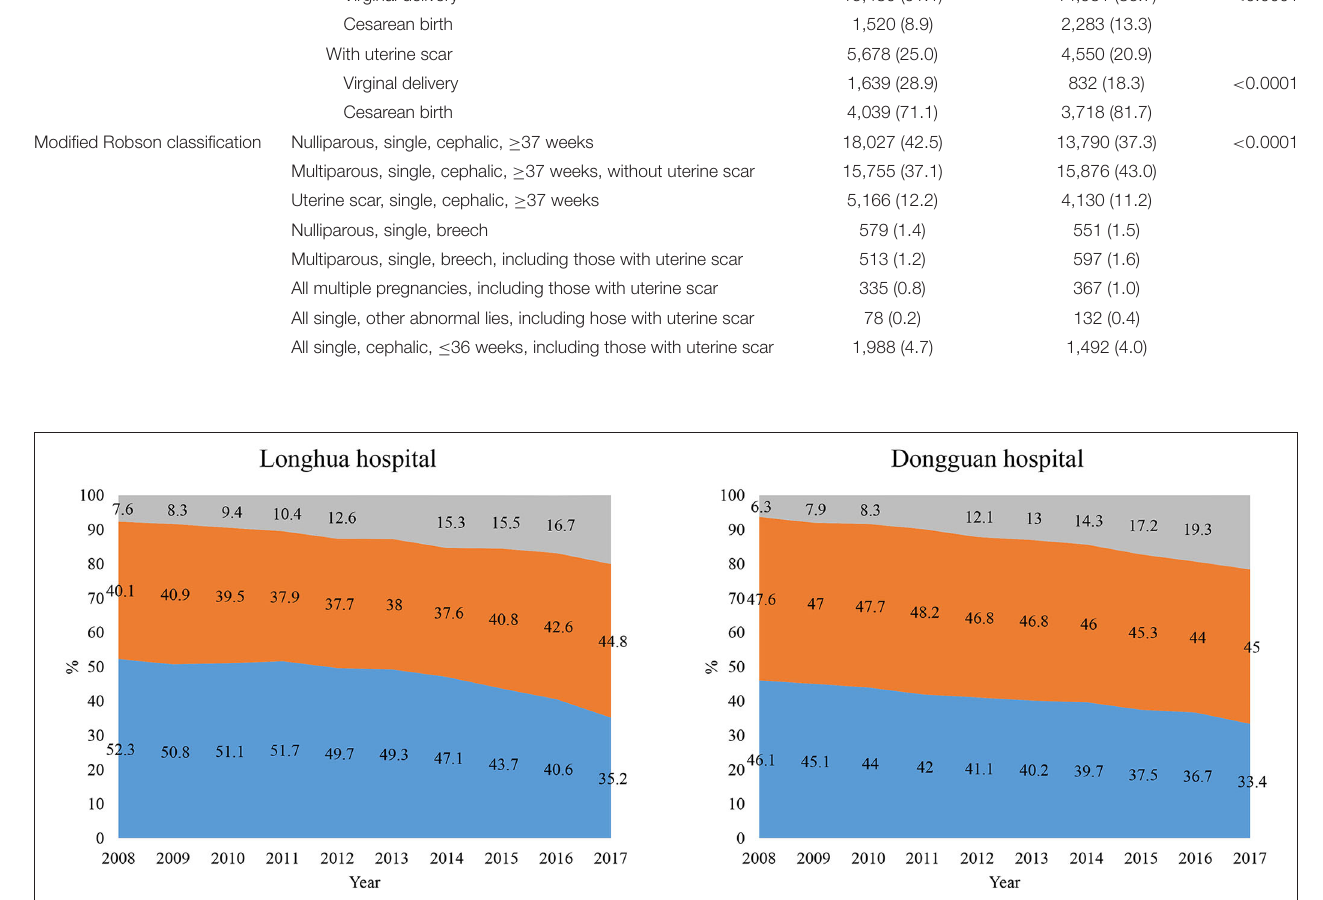
Frontiers in Medicine |